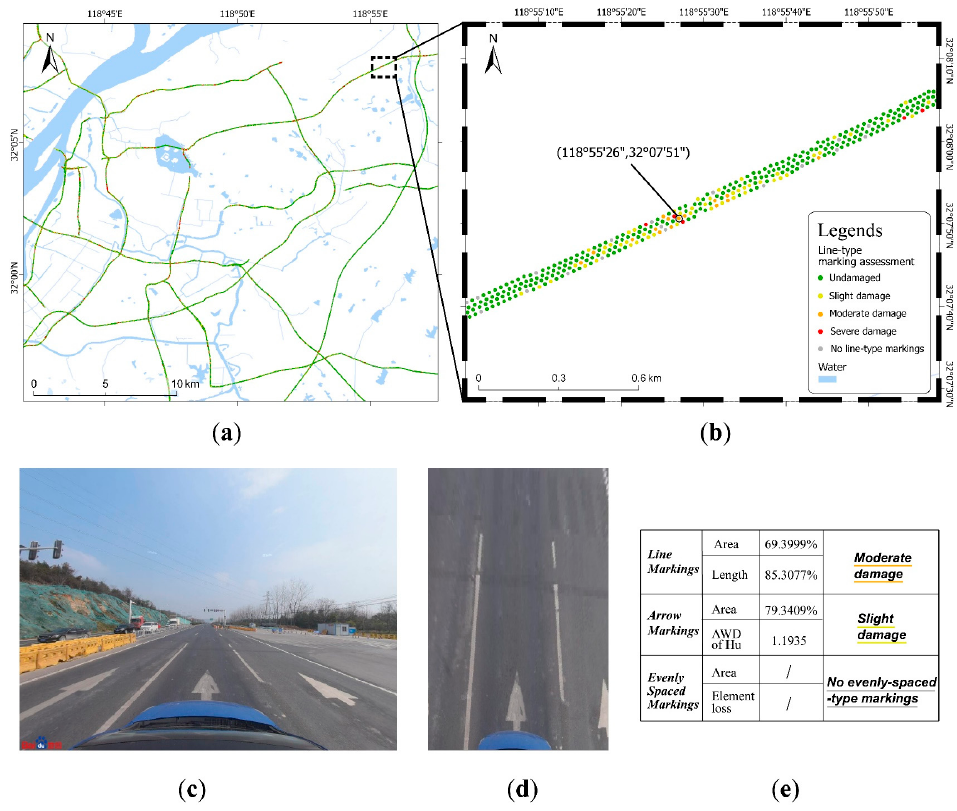
Figure 12. An example of road markings affected by both construction site and heavy-truck access. ( a ) Approximate location in Nanjing city, ( b ) explicit position of the images captured at sampling point, ( c ) original street-view image of the sampling point, ( d ) converted birds’-eye view of panel ( c ), ( e ) assessment of pavement markings at the sampling